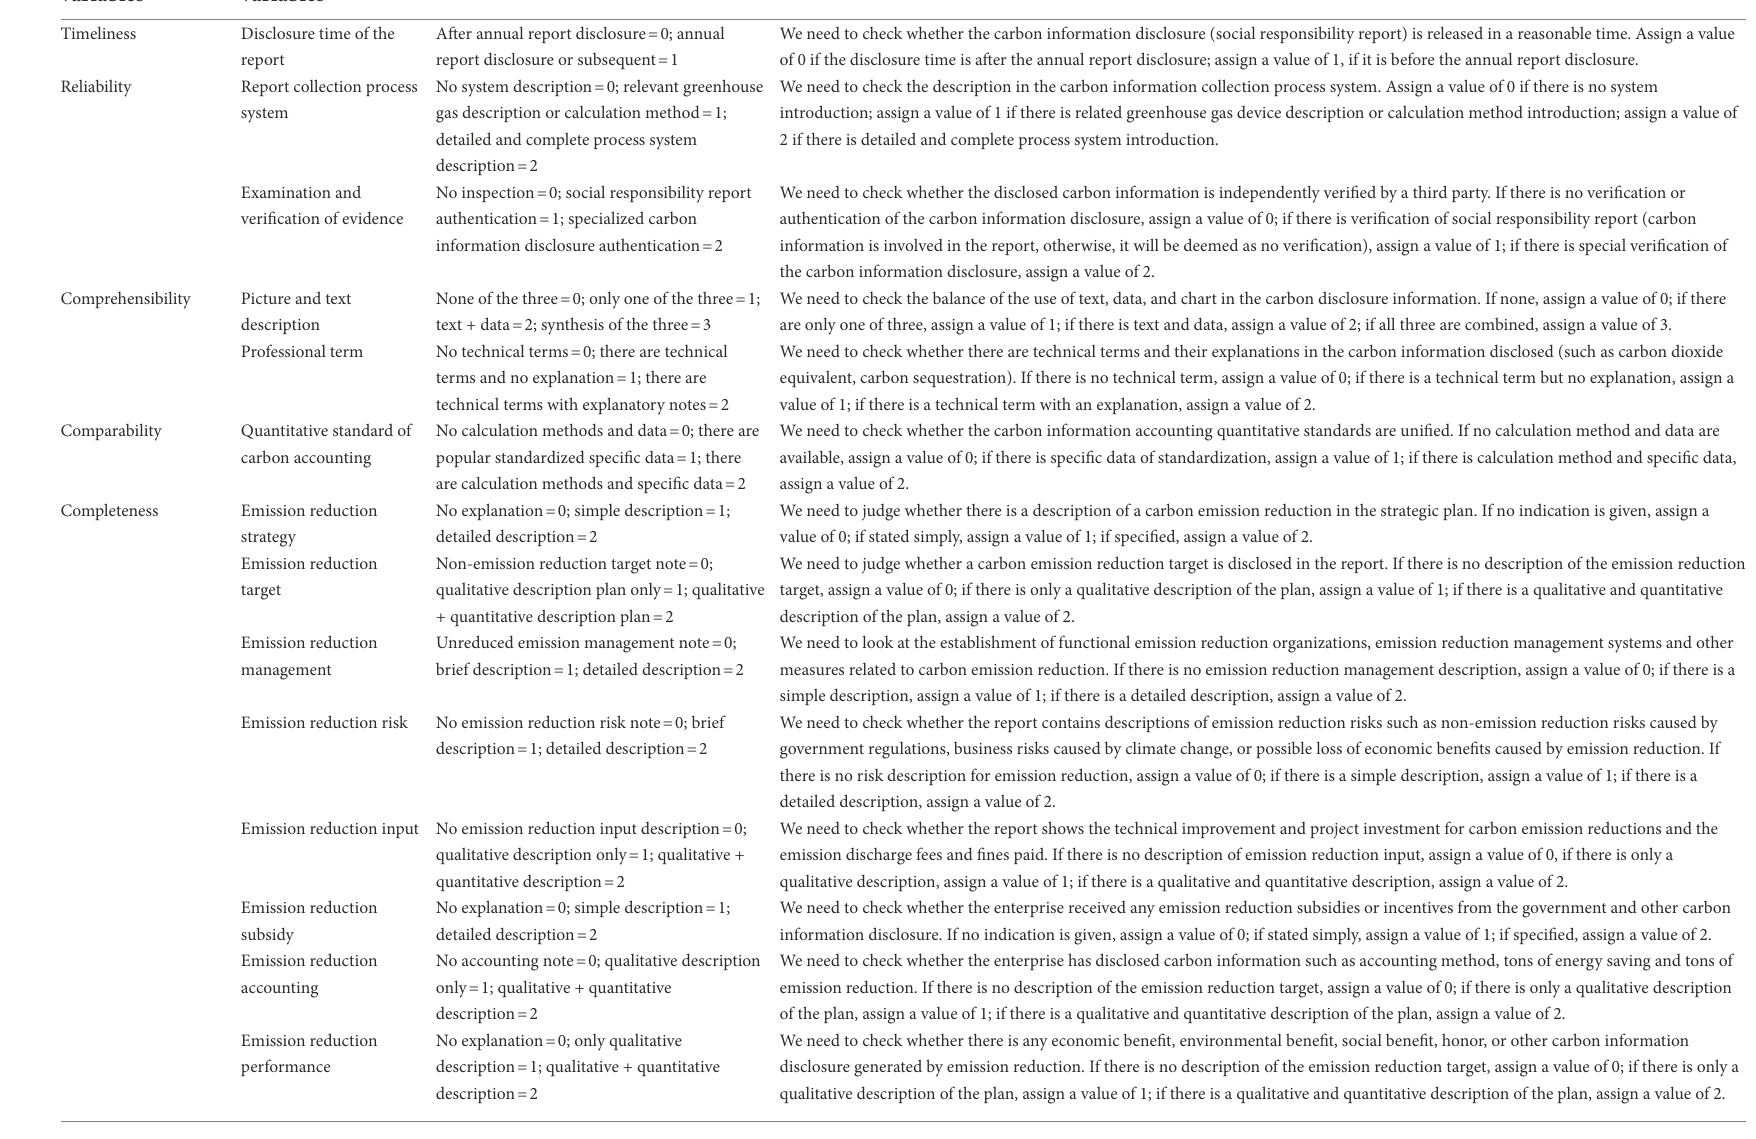
TABLE 1 Carbon information disclosure evaluation index